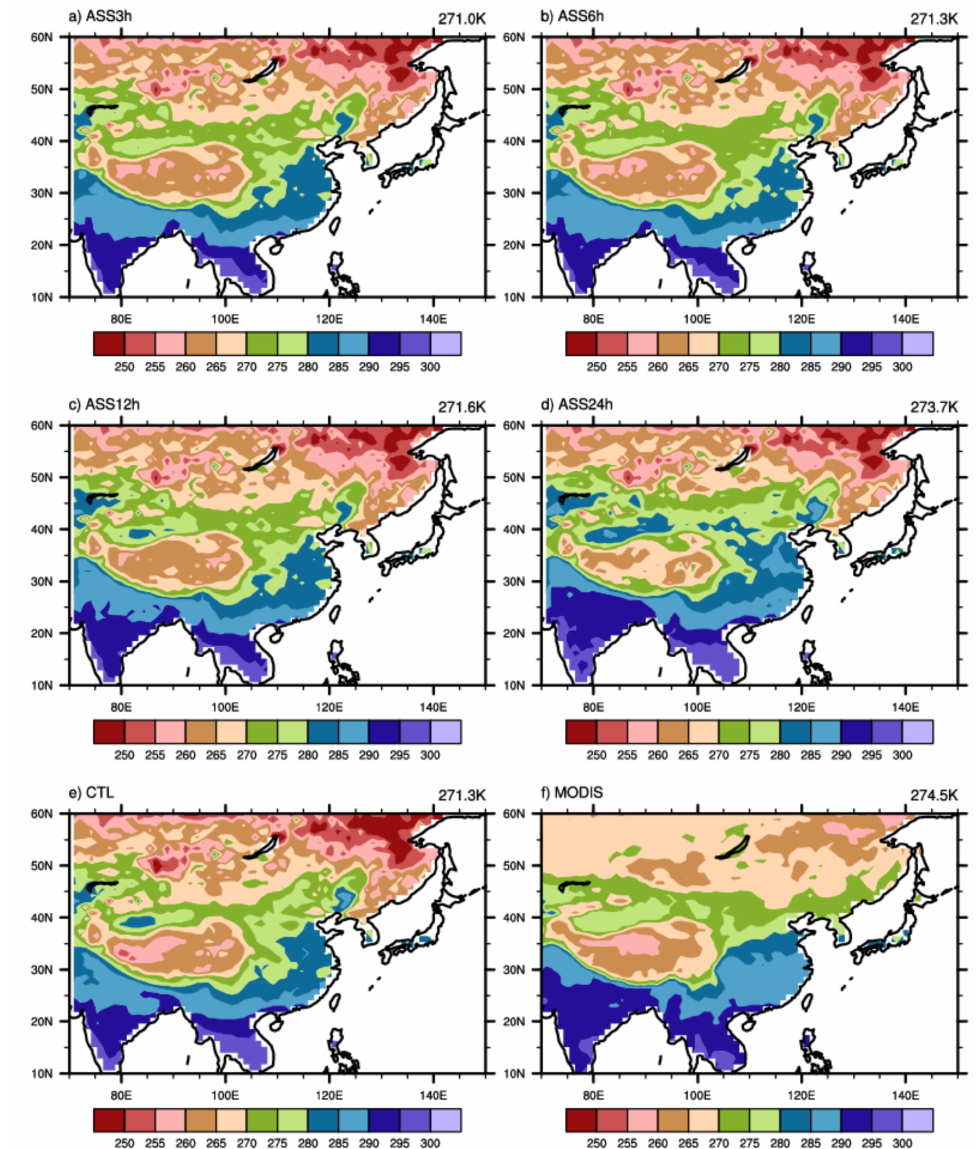
Figure 3. Same as in the Figure 2 but for the nighttime